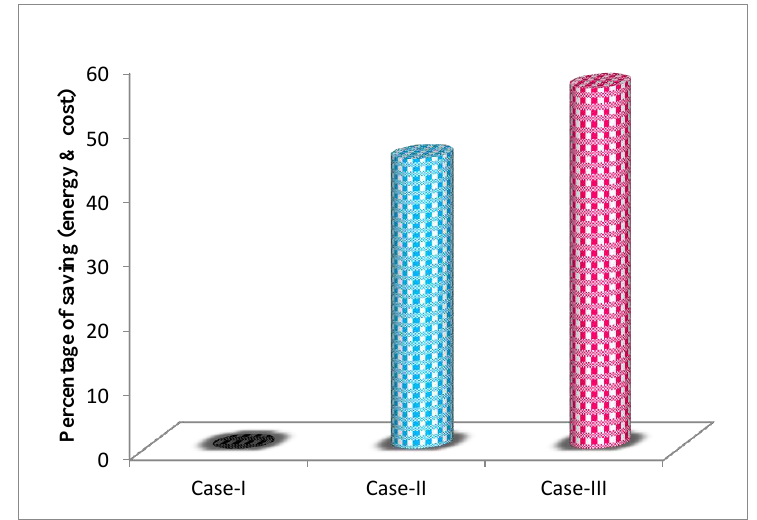
Figure 19. Comparison of the percentage of energy and cost saving for cases I, II and III.